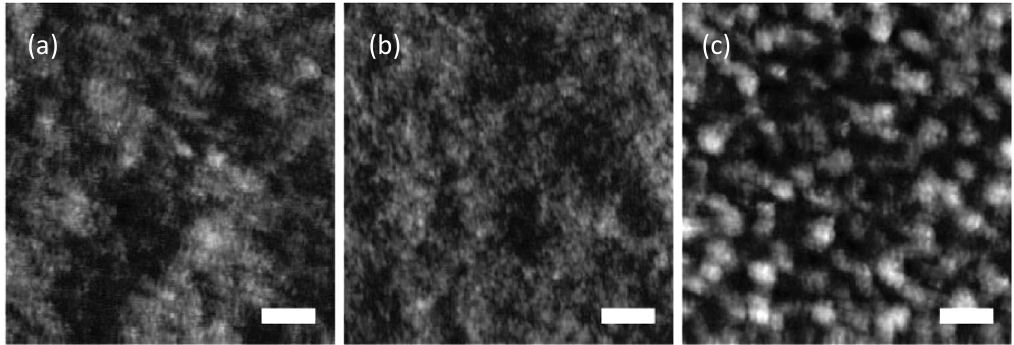
Figure 14. AFM topography ( a ) and phase-lag images; ( b,c ) of 50:50 wt% P3HT:PDB BHJ thin-film; ( d ) Size distribution of the phase-separated domains. (Reprinted